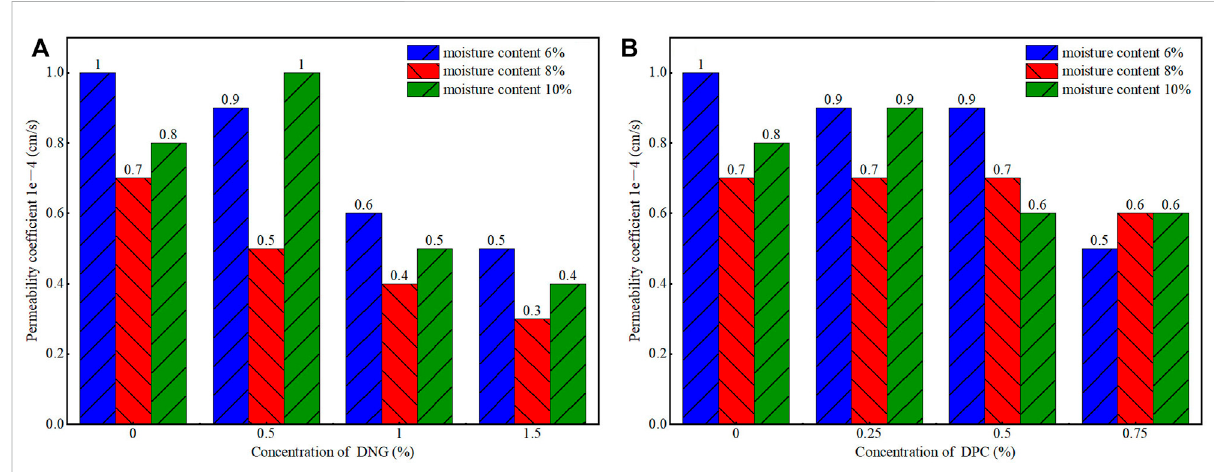
FIGURE 10 Permeability test results of PPE and silty sand mixture samples with different moisture content and concentration. Permeability coef fi cients of (A) DNG and silty sand samples and (B) DPC and silty sand